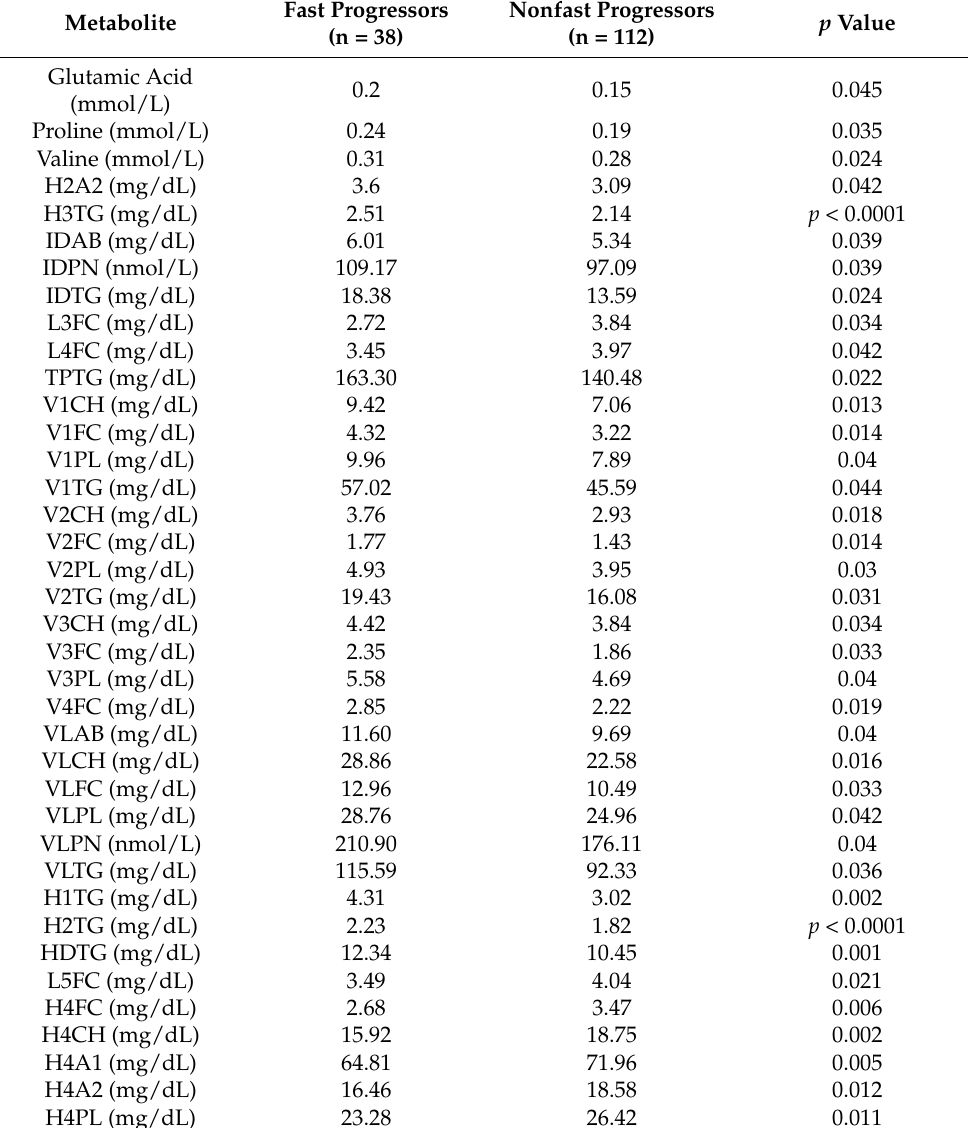
Table 2. Differences in metabolic profile between fast progressors and nonfast